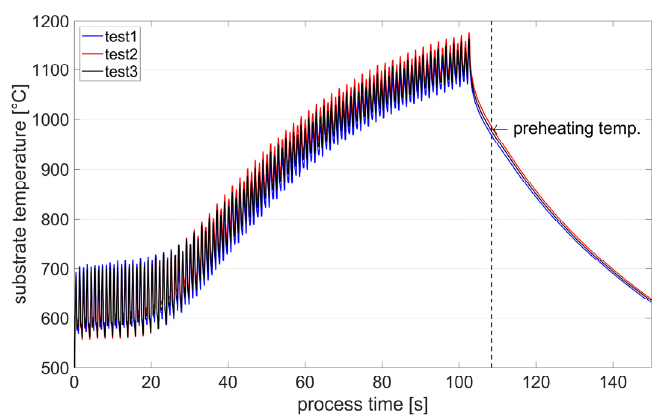
Figure 4. Temperature profiles of the developed laser preheating process. The initial substrate temperature for the following experiments was determined at a processing time of 108.45 s, as indicated by the dashed line.